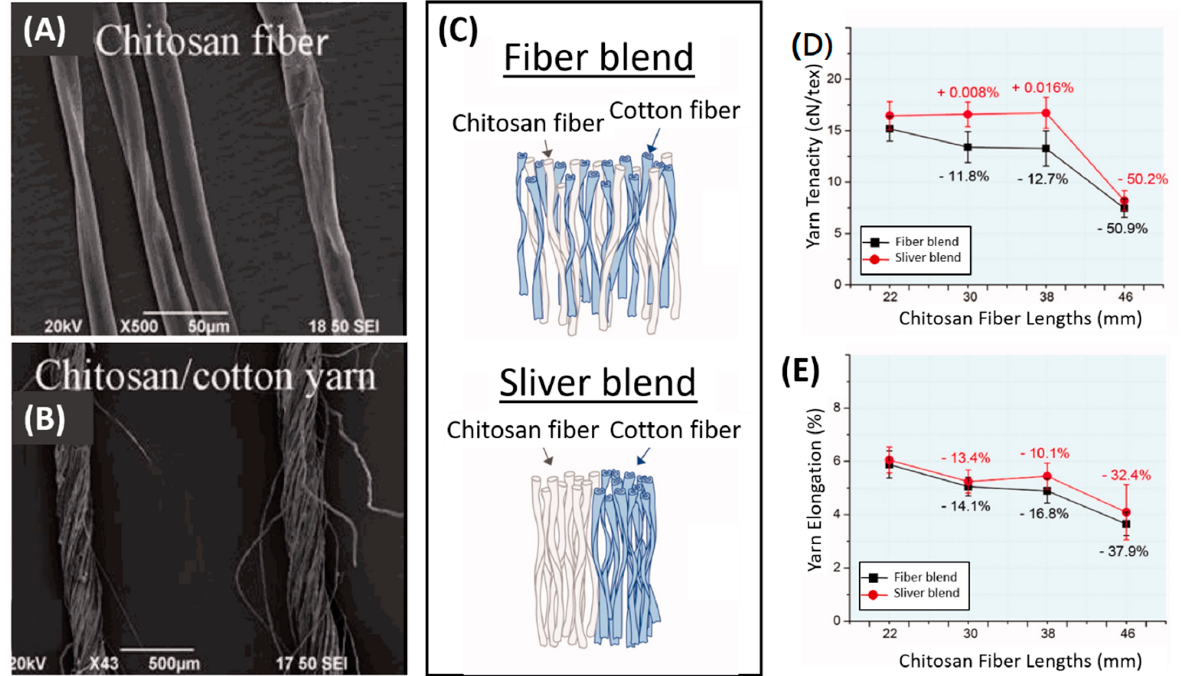
Figure 4. Micrograph images of surface structures in ( A ) chitosan fiber and ( B ) chitosan/cotton yarn. ( C ) Illustration of the blending methods. The yarn fiber blend showed higher ( D ) tenacity and ( E ) elongation than the yarn sliver blend at all chitosan fiber lengths. Reprinted with permission from [80,81], copyright 2014 & 2017 SAGE